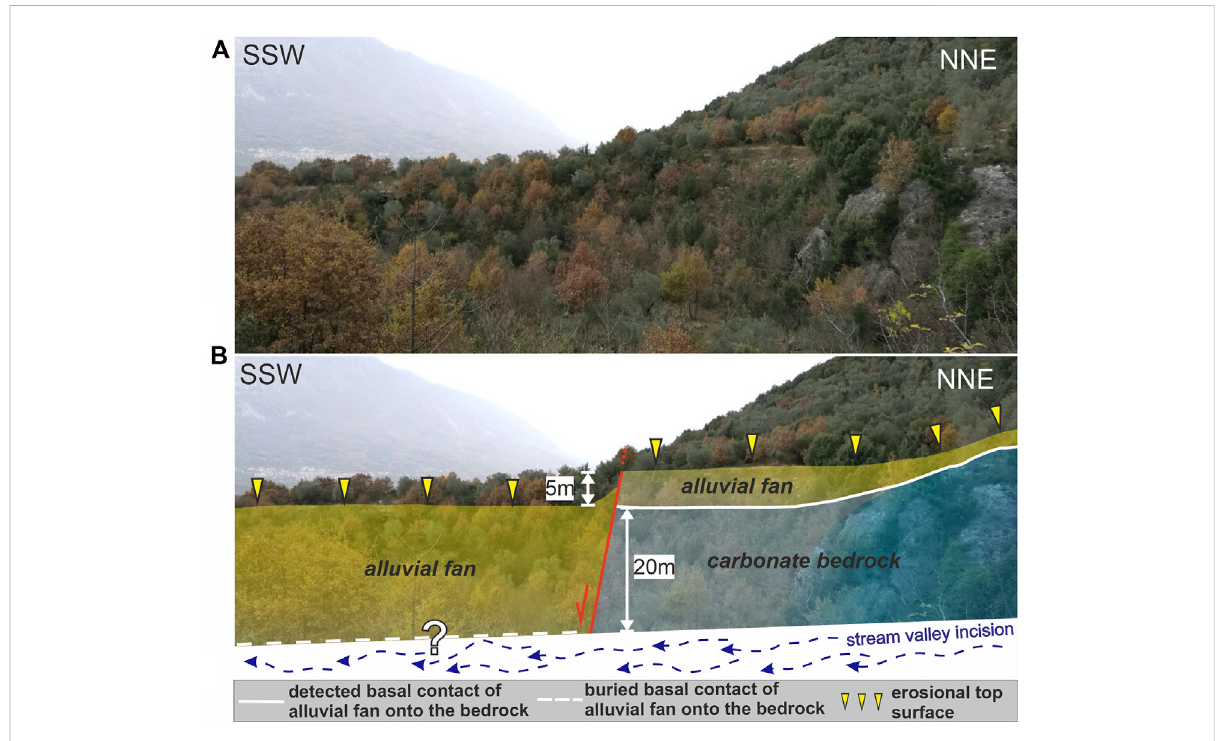
FIGURE 5 The “ La Stretta-a ” site. (A) View (to the WNW) of the right fl ank of the incision that exposes the “ La Stretta ” alluvial fan. (B) Structural and stratigraphic setting of the area, showing the displacement of the alluvial fan due to the Roveto Valley Fault